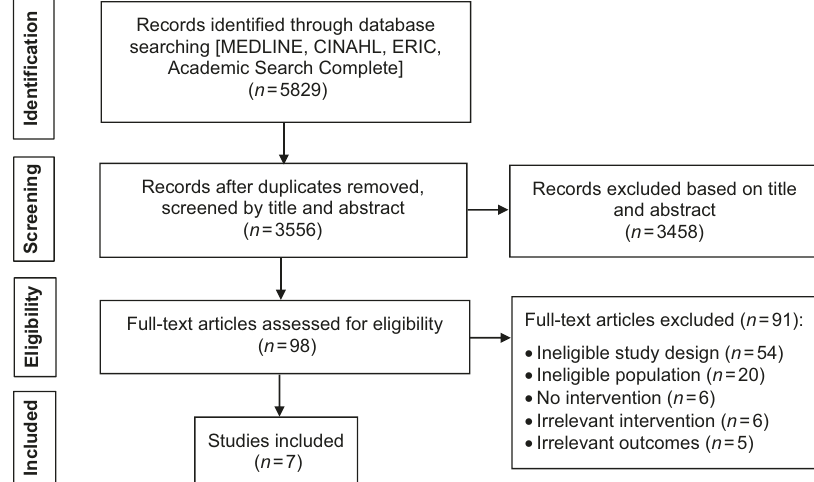
Fig. 1 PRISMA fl ow diagram. Study identi fi cation, screening, and selection